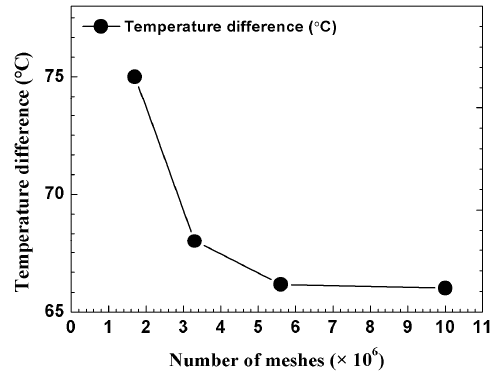
Figure 5. Mesh independence analysis results.